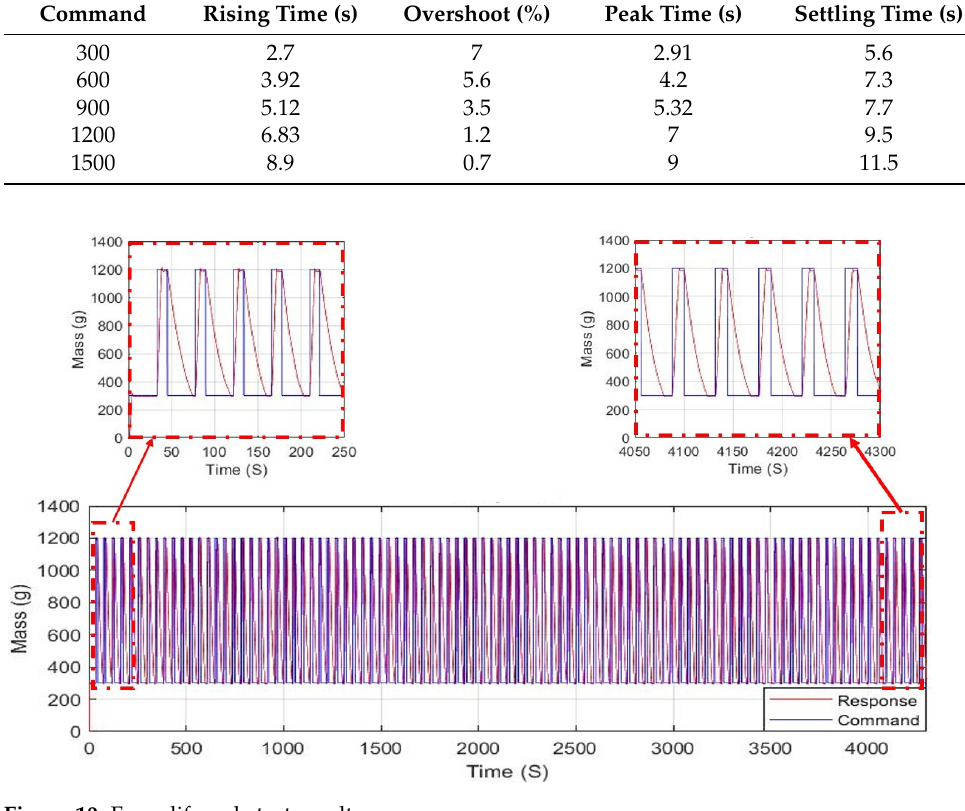
Figure 10. Force lifecycle test results.